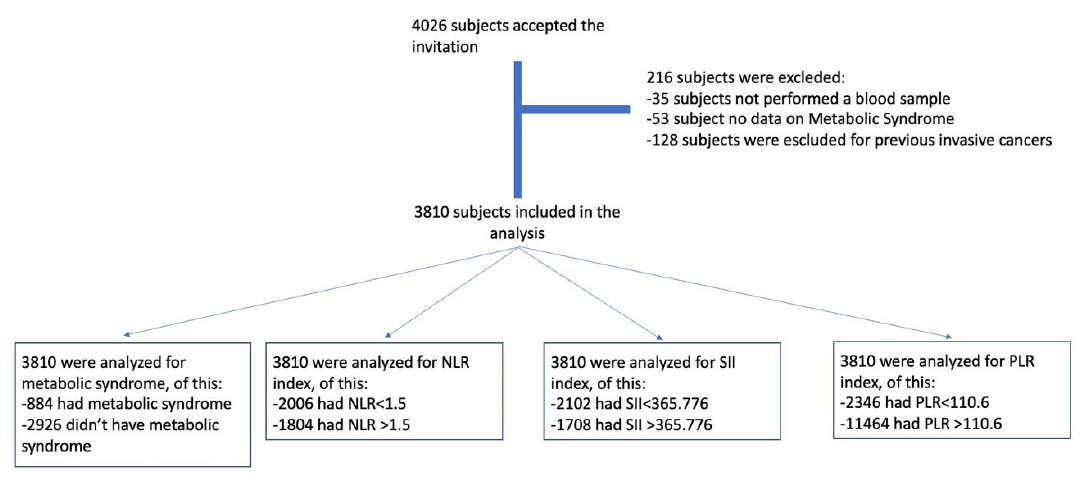
Figure 1. Flow chart of the study.